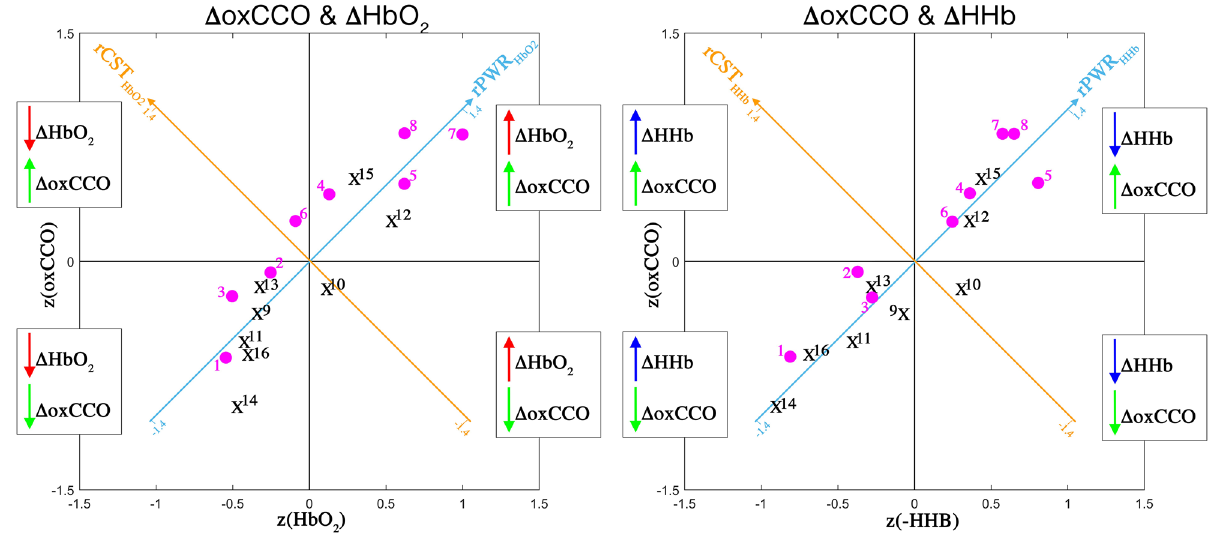
Figure 4. Visual representation of rPWR and rCST for the Right condition. These parameters were computed from the median β-values which were z-scored across channels and then averaged across all participants, for HbO 2 and oxCCO (left) and HHb and oxCCO (right) by rotating of 45° along the haemodynamics and metabolism axis, yielding to a rPWR axis (light blue) and rCST axis (orange). bNIRS channels located in the left hemisphere (# 1–8) are indicated by magenta circles and black crosses indicate channels located in the right hemisphere (# 9–16). The map is divided into four quadrants based on the direction and relative magnitude of the chromophores’ changes (greater increase or decrease) across